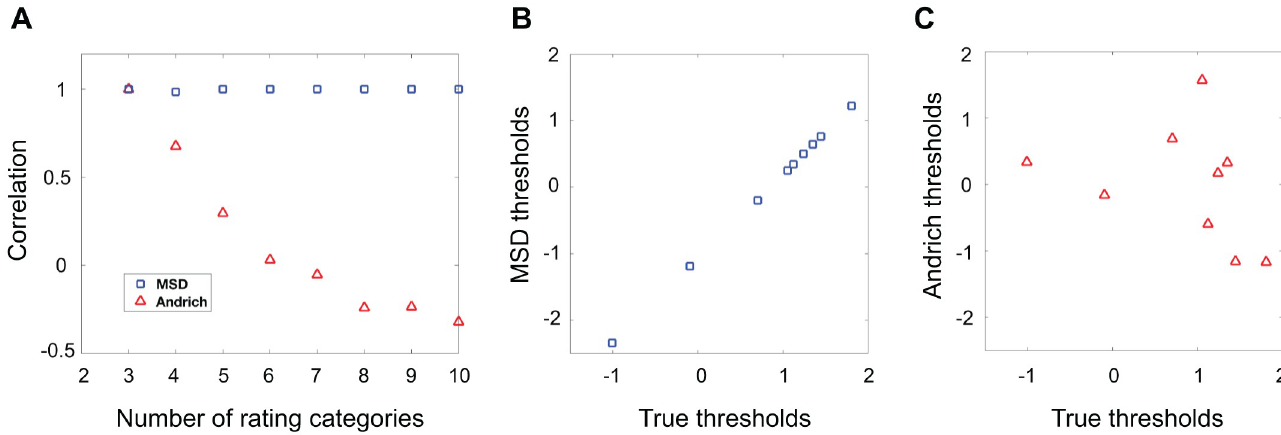
Fig 4. Comparing estimated vs. true thresholds for the Andrich model and MSD. Correlations between estimated thresholds and true thresholds for MSD (blue squares) and the Andrich model (red triangles). Fig 4A shows that the correlation between estimated and true thresholds is nearly perfect for MSD, with r > 0.999 across all conditions except when there were 4 rating categories where r = 0.985. The correlation between thresholds estimated by the Andrich model and the true thresholds turned negative with a sufficiently high number of rating categories. Fig 4B shows an example of MSD thresholds vs. true thresholds with 10 rating categories, and Fig 4C shows an example of Andrich thresholds vs. true thresholds for the same condition.